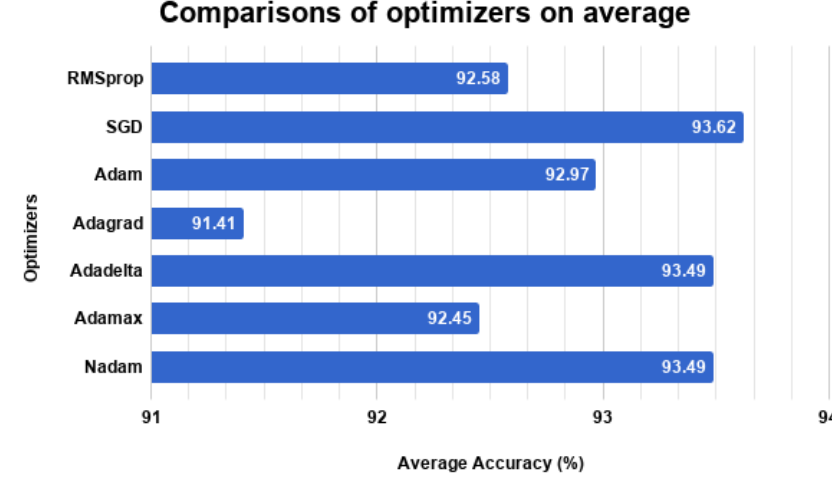
Figure 17. Stochastic Gradient Descent (SGD), Adadelta, and Nadam were primarily used in experiments based on their performance. Later, SGD was used